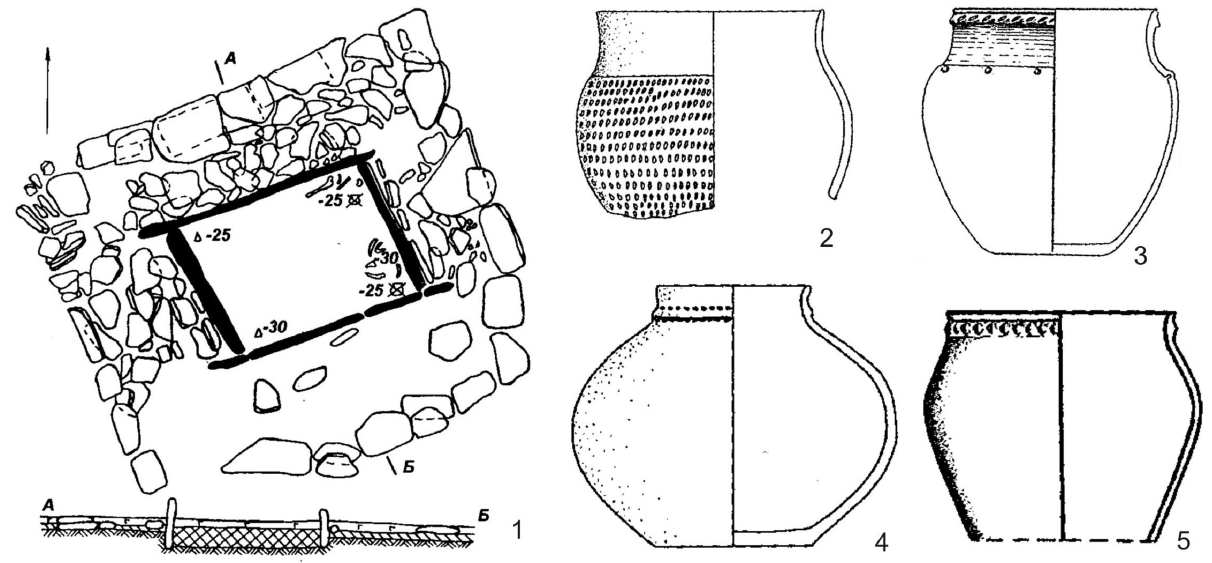
Figure 5: Begazi-Dandibay complexes: 1, 2, 4 – Dongal; 3 – Kent, 5 – Domalaktas (after Evdokimov & Varfolomeev, 2002).